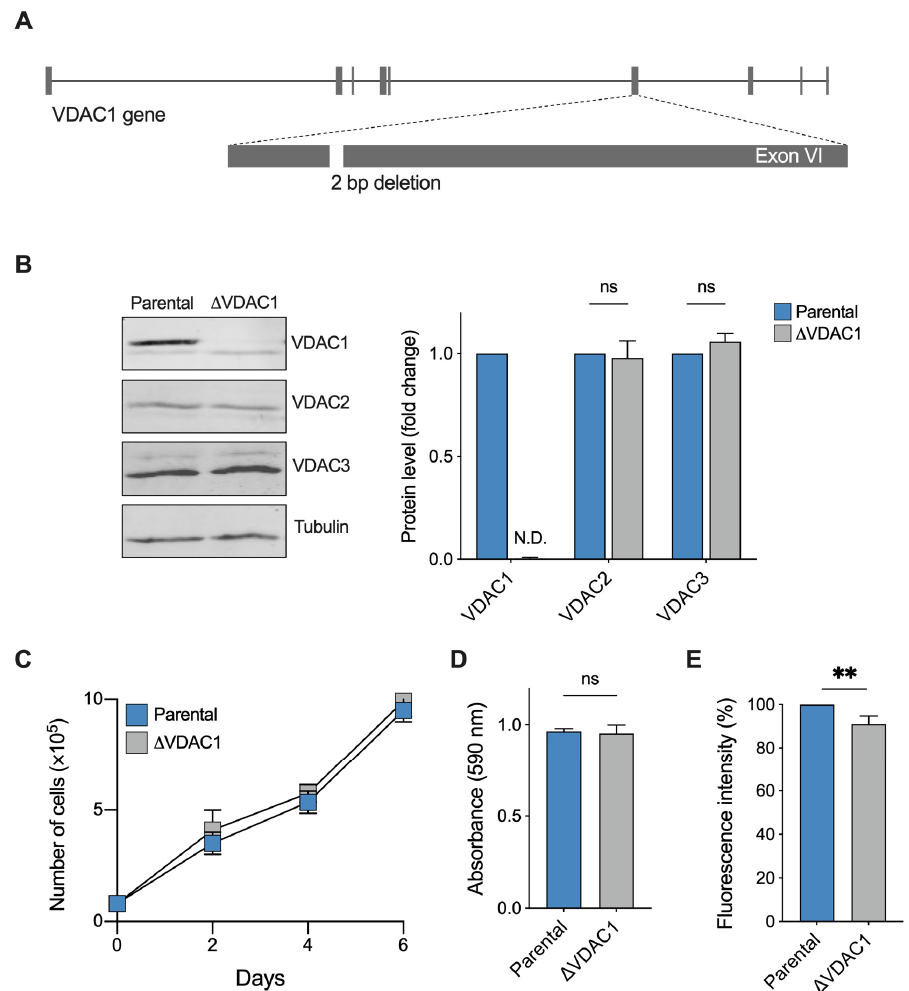
Figure 1. Phenotypical characterization of HAP1 cells used in this work. ( A ) Schematization of VDAC1 knock-out: a 2 bp deletion in the exon VI of VDAC1 gene was performed. ( B ) Representative Western blotting (left) and the relative protein level quantification (right) of total lysates from parental and ∆ VDAC1 cells, showing the expression of the three VDAC isoforms. As expected, no VDAC1 protein band was detected in knock-out cells. N.D.—not detectable. ( C ) Proliferation assay showing no significant difference between samples. Data are shown as mean ± SD of n = 3 independent counts and statistically analyzed by two-way ANOVA; ns—not significant. ( D ) Cell viability analysis by MTT assay showing no significant difference between samples. ( E ) Quantification of the MitoTraker signal in parental and ∆ VDAC1 cells by flow cytometry. A slight but significant difference of approximately 10% was observed. Data in ( D , E ) are expressed as mean ± SEM of n = 3 independent counts and statistically analyzed by unpaired t -test, with ** p < 0.01; ns—not significant.